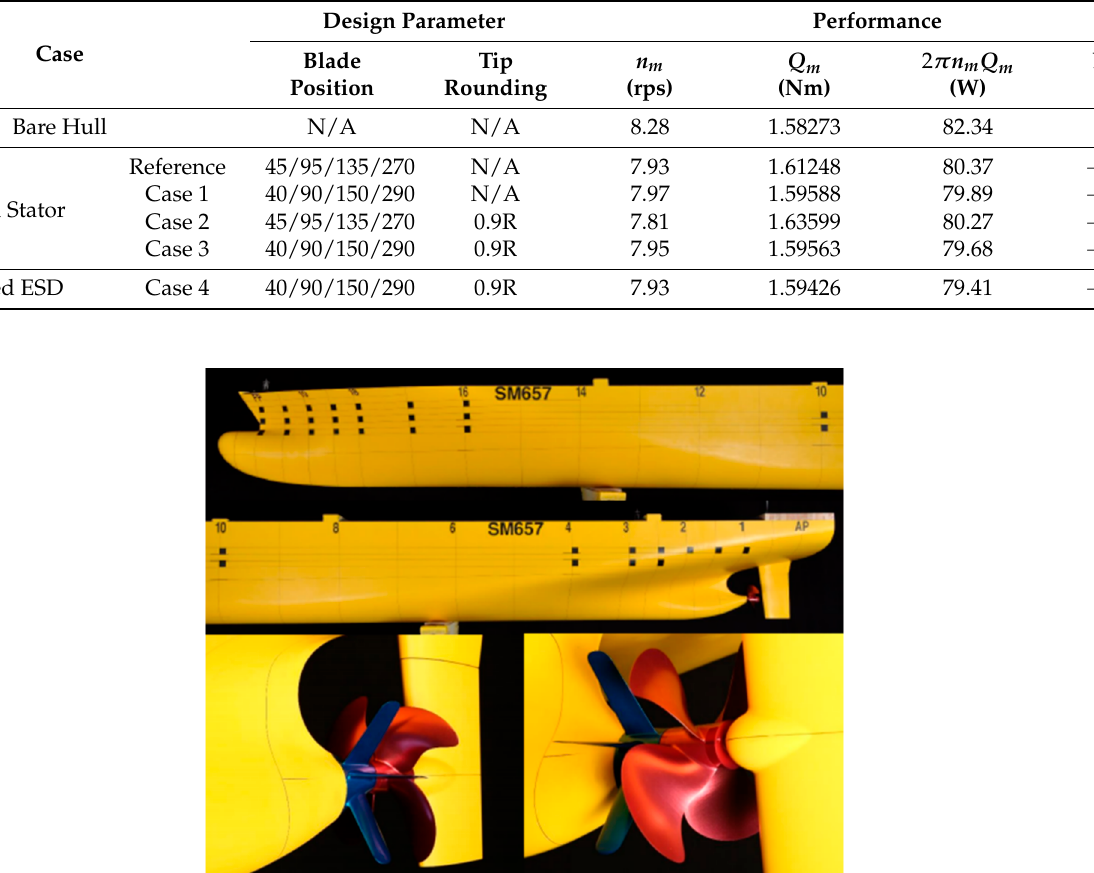
Table 8. Comparison of propulsive performances according to the case study by CFD.